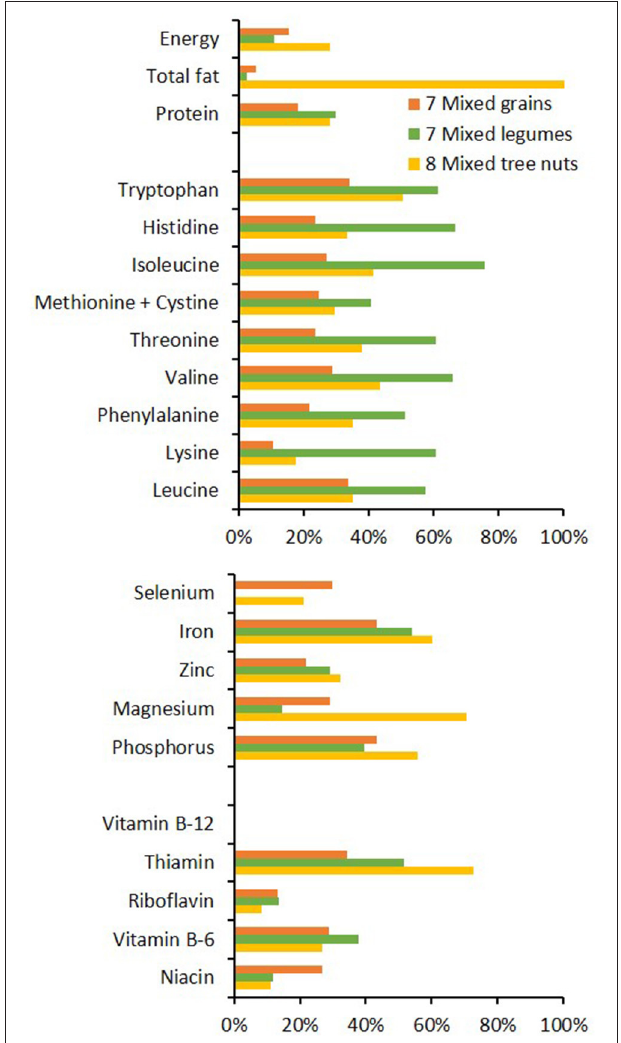
FIGURE 3 | Typical content of key nutrients in lean muscle meat, heart and liver, shown here as the averaged values of lamb, beef, and pork sources ( 78) and expressed as a proportion of the adult male RDA (66) that would be provided by a 100g raw serving. Items within nutrient classes are ordered by their increasing dietary requirement: amino acids 5–42 mg/kg bodyweight/day, minerals 55 µ g − 1,200 mg/day, vitamins 2.4 µ g − 14 mg/day. Calculations were based on the materials’ raw native state, therefore water content is higher and nutrient concentrations are concomitantly lower than would be expected in the cooked versions of these foods.